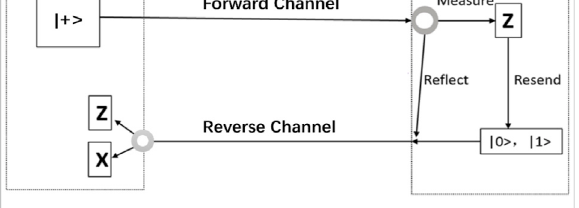
FIGURE 2 The typical setup of a single-state SOKD protocol. Re fl ect is Ctrl,meaningthatBobre fl ectsthequbitbacktoAliceundisturbed. Measure and Resend is Sift, meaning that Bob measures it in the Z basis and resends it to Alice in the same state that he found it. For the returned qubit, Alice chooses to measure it on the Z or the X basis